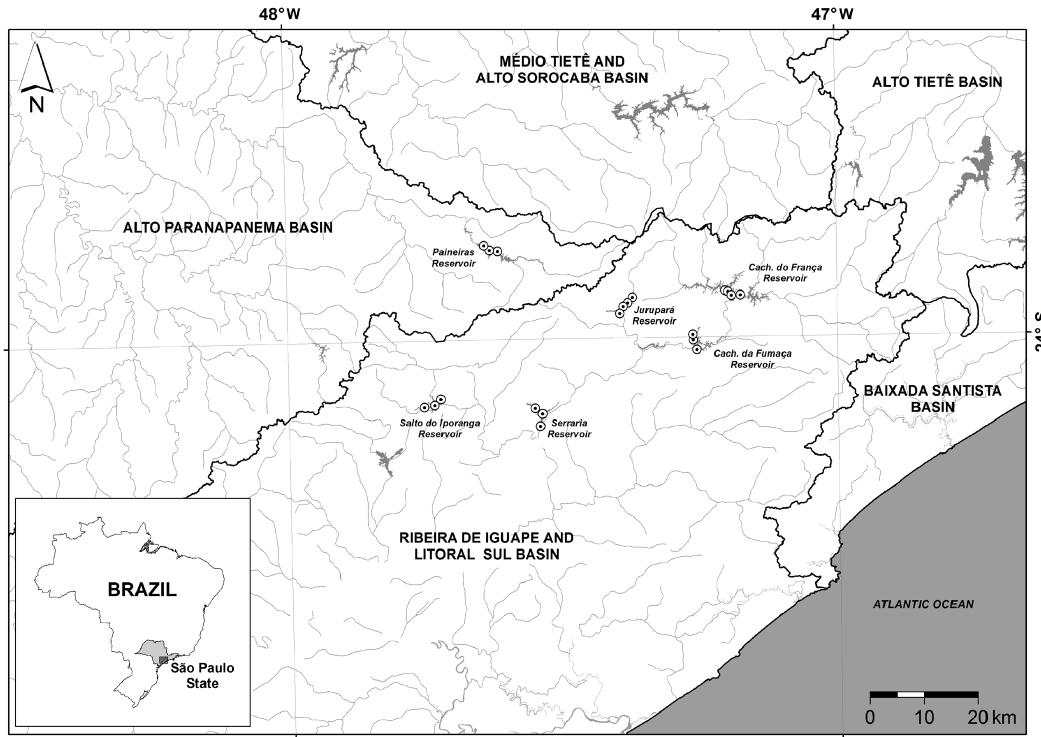
Figure 1. Study area and sampling